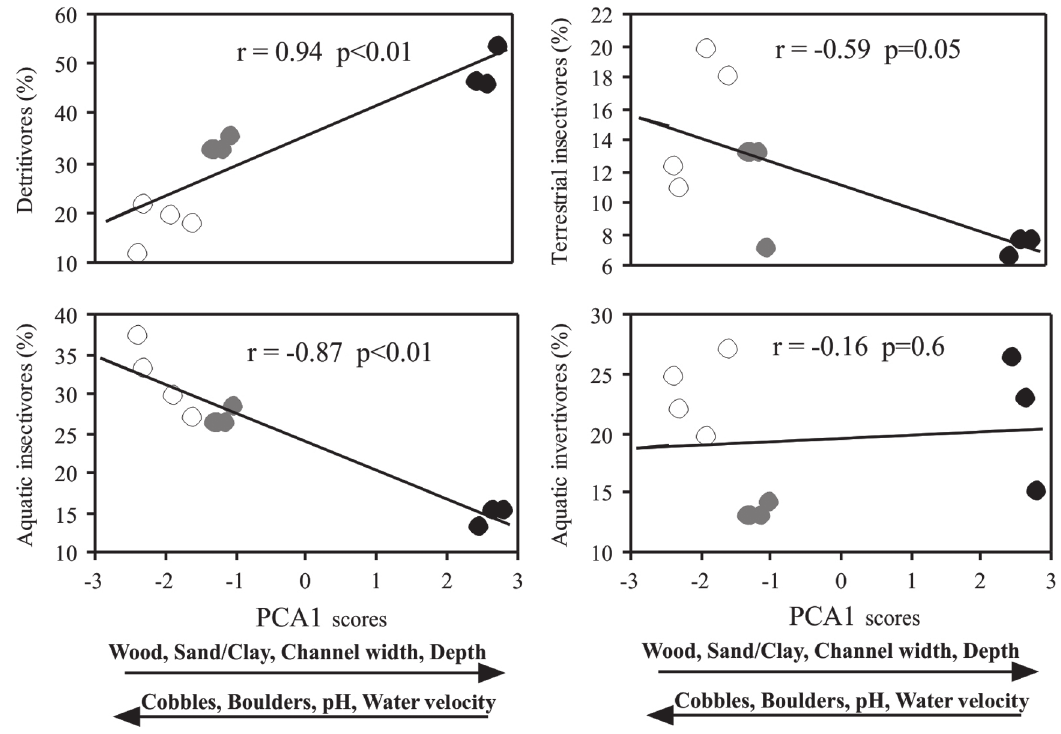
Fig. 7. Spearman correlations between the distribution (percentage frequency) of guilds and scores of the first axis of the principal components analysis (PCA1) applied to the correlation matrix of abiotic variables. White circle = headwaters; gray circle = middle stretch; and black circle = mouth of the Vermelho River, East Atlantic basin, Antonina, Paraná State,